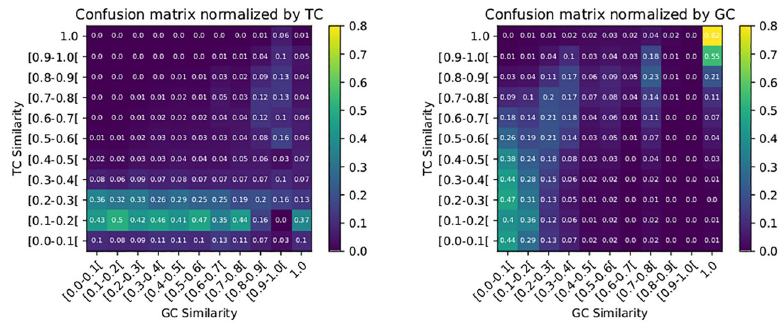
Fig 6. (a)Confusion matrix normalized by TC (b)Confusion matrix normalized by GC. We see it as the conditional probability distribution: given a x GC similarity value (resp., TC) and given a randomly selected pair of molecules whose GC similarity is x (resp., TC), what is the probability that the similarity TC (or GC) is y ?